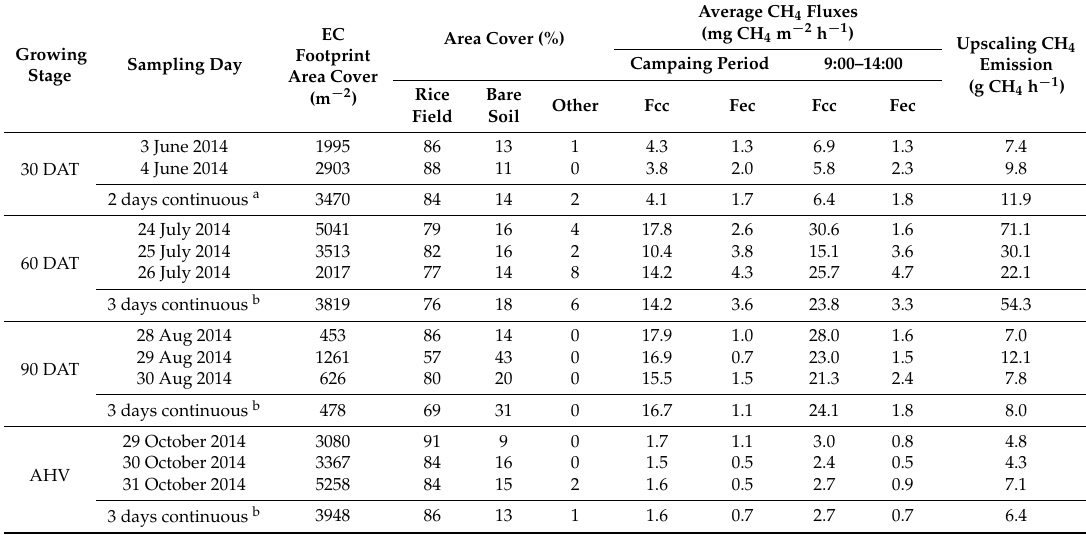
Table 3. The area covered by the eddy covariance method (at 80% cumulative EC footprint) for each sampling time, average CH 4 emission values and the upscaling of CH 4 flux estimates from seasonal CH 4 using the CC